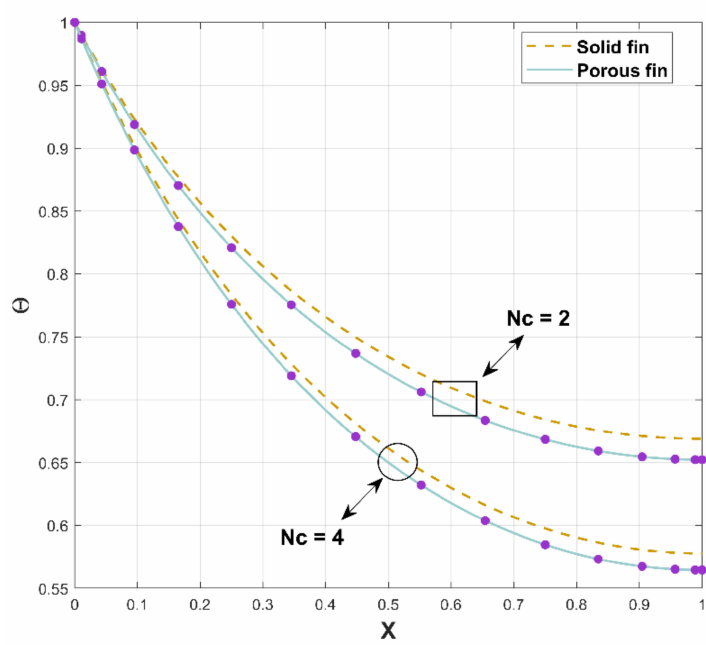
Figure 6. Thermal distribution through porous and solid